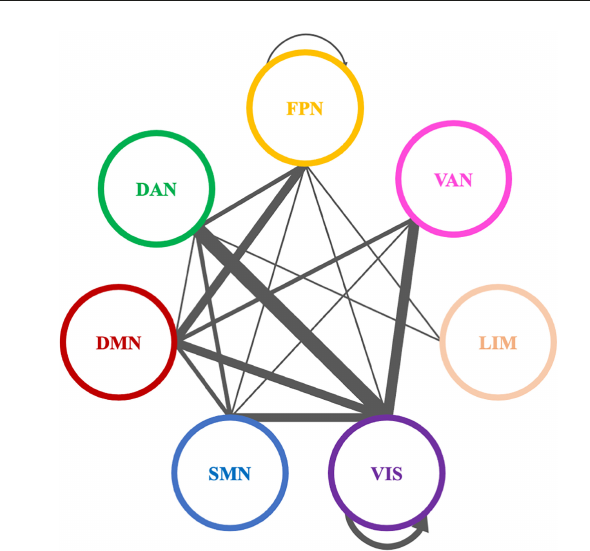
FIGURE10 Significantly modified connections of beta PLI networks across time (T0, T1, T2), between or within the seven resting state networks (RSNs; Thomas Yeo et al., 2011). Line weight corresponds to number of significant connections. Most changes were observed in connections between default mode network and visual network or within the default mode network. DAN, dorsal attention network; DMN, default modenetwork;LIM,limbicnetwork;FPN,frontoparietalnetwork;SMN, somatomotor network; VAN, ventral attention network; VIS,